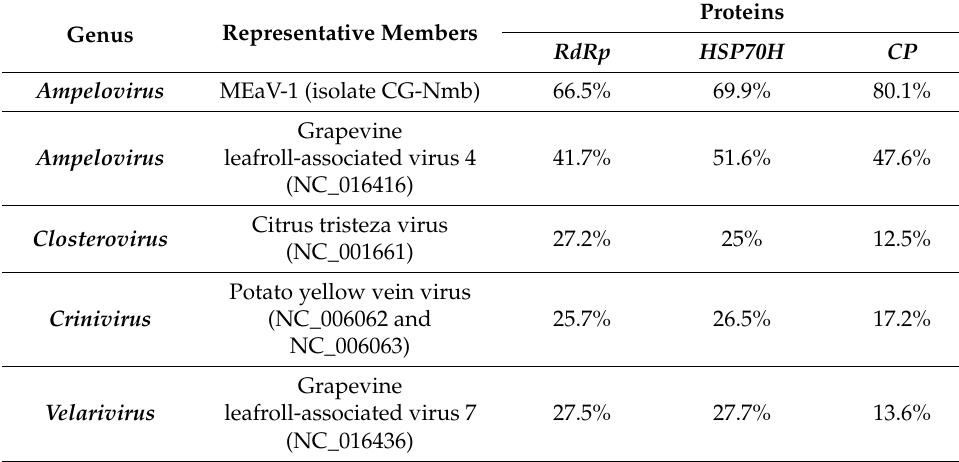
Table 6. Amino acid sequence identity of the RdRp, HSP70h and CP of MEaV-2 (isolate MG-Men-9)